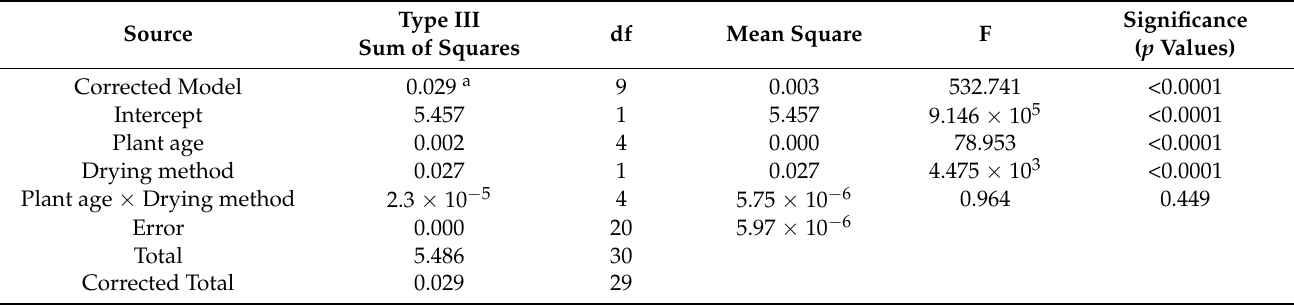
Table 2. ANOVA results of steam-distilled, extracted mint